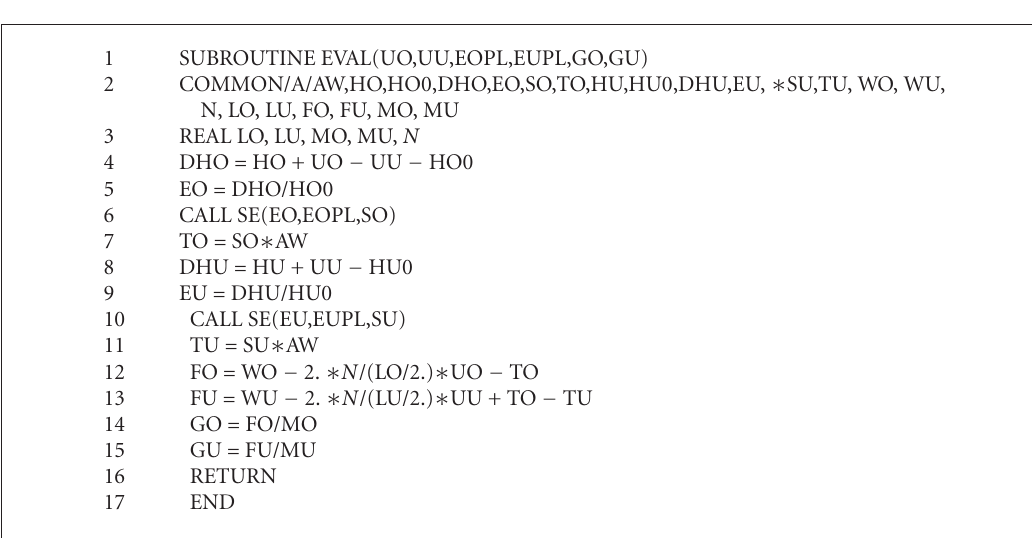
Algorithm 2: Subroutine EVAL.